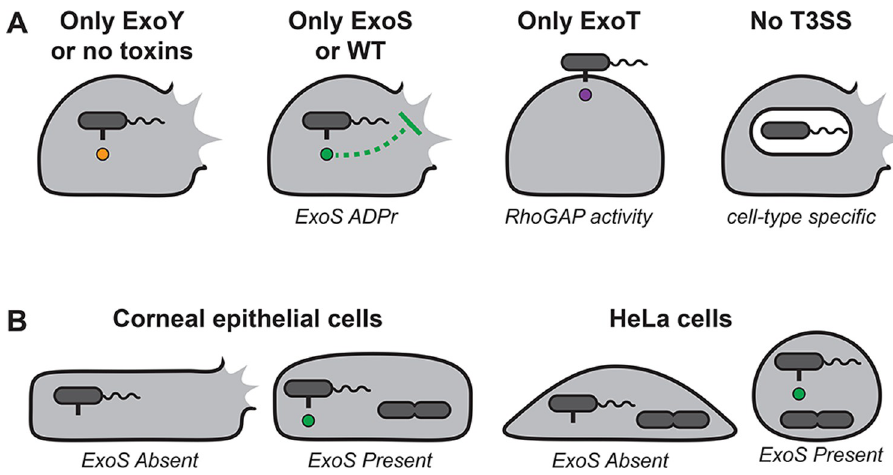
Fig 11. (A) Diagram depicting the outcomes on host cells of expressing individual T3SS effectors showing: 1) Whether bacteria are most likely to become cytoplasmic, vacuolar, or remain extracellular, and 2) whether these conditions lead to lytic death of host cells. (B) Diagram depicting the same outcomes as above relating to ExoS expression in corneal epithelial cells or HeLa cells.